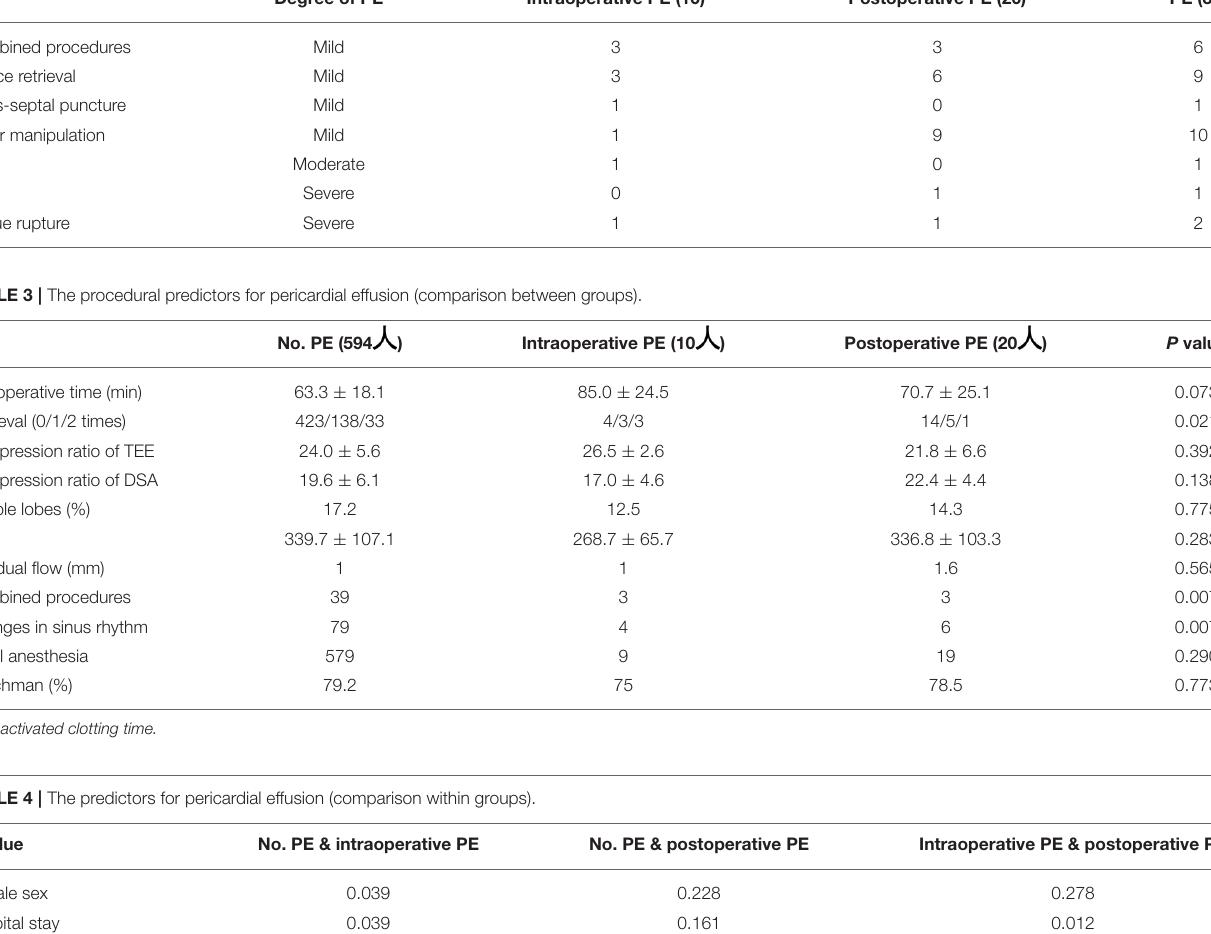
TABLE 2 | The predictors of pericardial effusion relating to procedural manipulation.